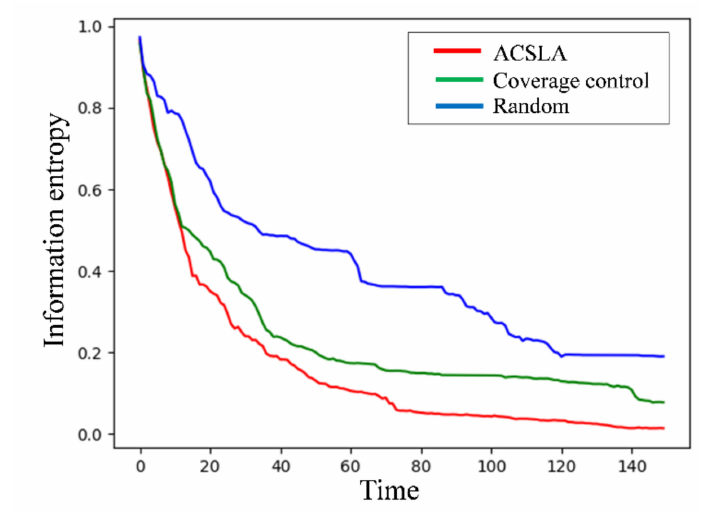
Figure 8. Changes in information entropy of the di ff erent search